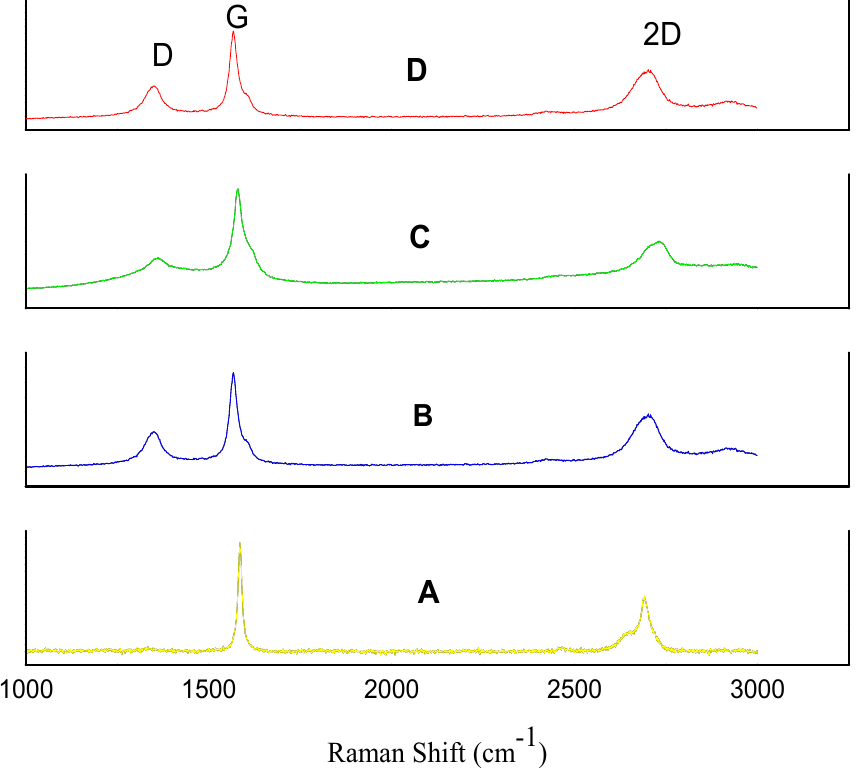
Figure 1. Raman spectra of: ( A ) Graphite powder; ( B ) Graphene nano-platelets (GNPs) type 1 powders; ( C ) GNPs type 2 powders and ( D ) GNPs type 3 powders.